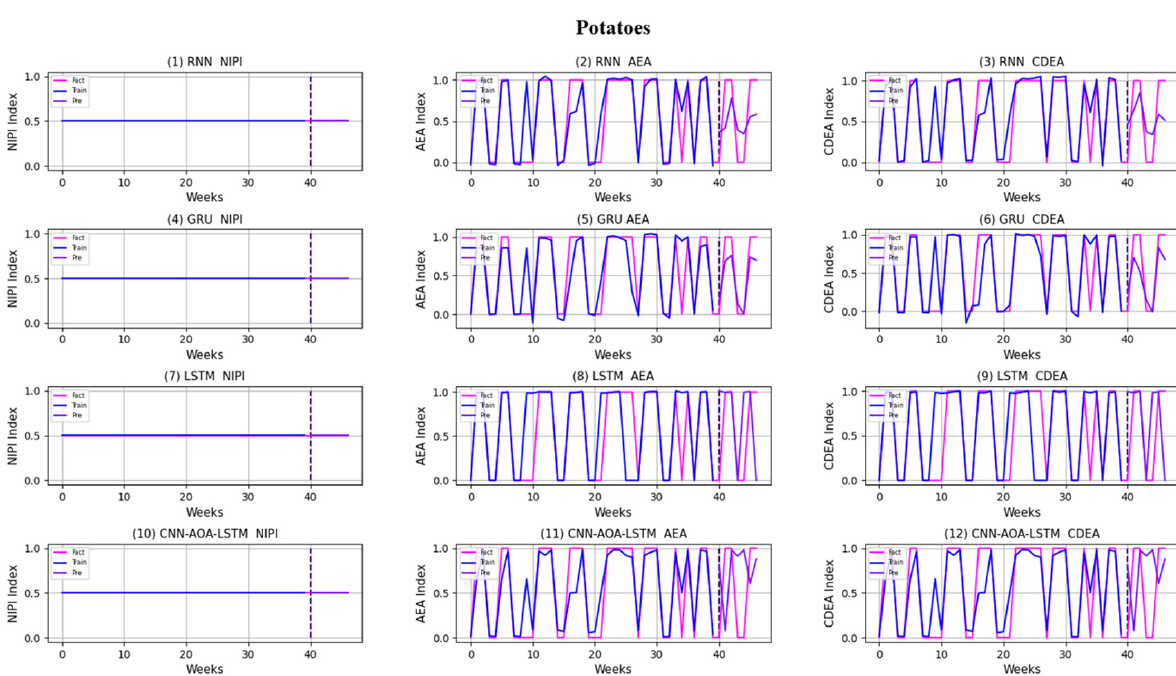
Figure 14. Prediction results of indexes of brassica vegetables.